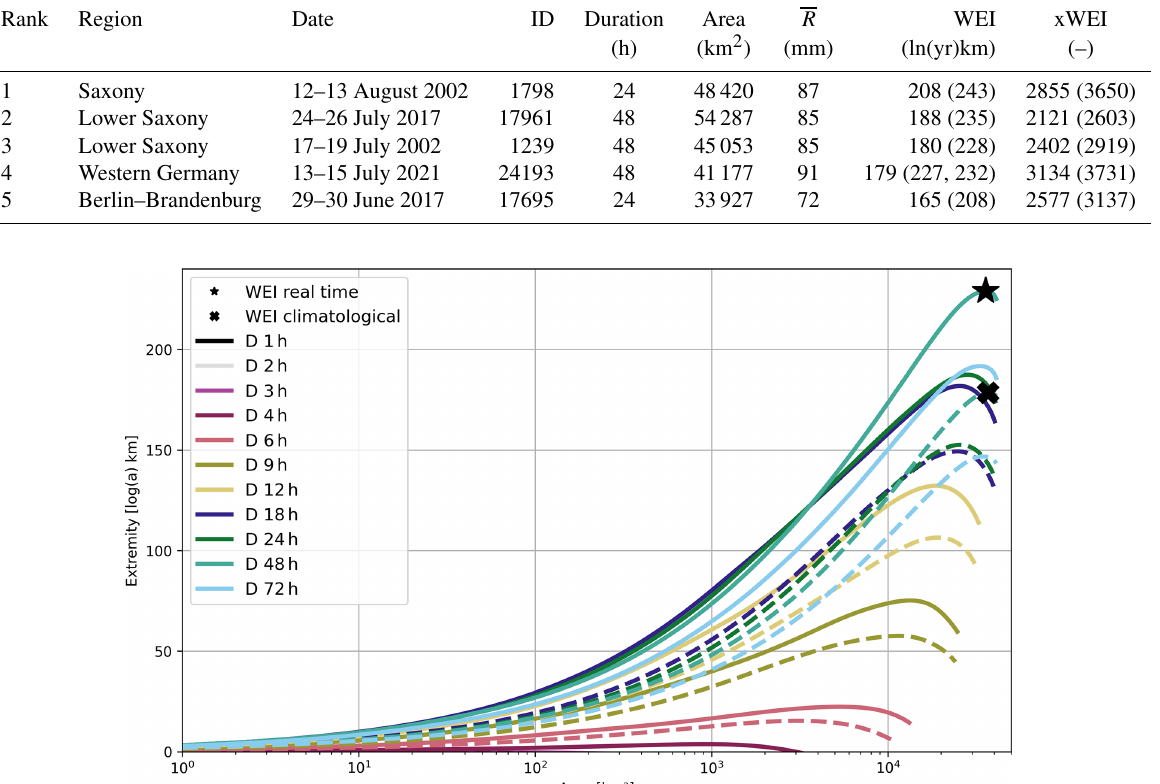
Figure 2. Extremity calculated for 14 July 2021 at 23:50UTC with operational RADOLAN data and GEV parameters obtained from RAD- KLIM 2001–2020 (real-time setup: solid lines, without including the year 2021 in the GEV parameter estimation, WEI marked with a star) and from reprocessed RADKLIM data (Version 2017.002) and GEV parameters from RADKLIM 2001–2021 (climatological setup: dashed lines, including the year 2021 in the GEV parameter estimation, WEI marked with an